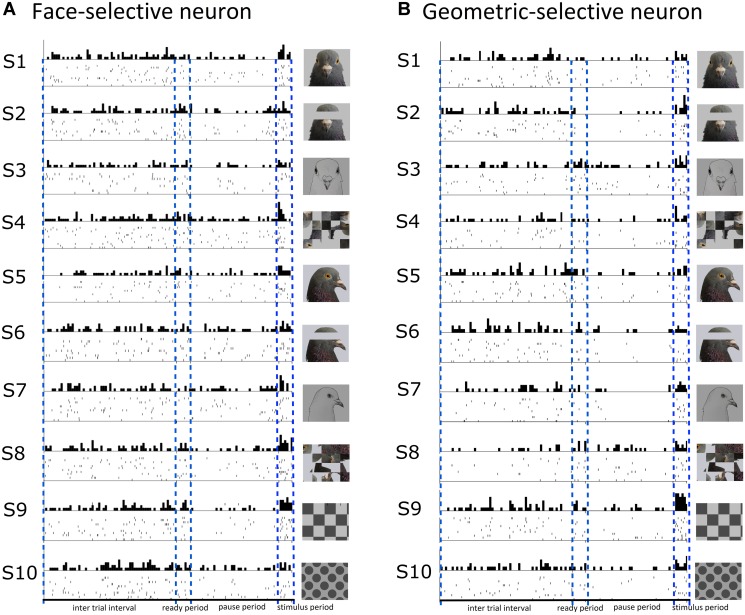
Raster and histogram plots of a neuron classified as face-selective (A) and geometric-selective (B). (A) Example of a neuron in the posterior entopallium that exhibited excitatory firing at a significant level to the stimulus S1 (portrait face) relative to the ITI, but also responded to the other stimuli during the stimulus period. (B) A neuron in the posterior entopallium that fired in an excitatory manner at a significant level to a geometric stimulus S9 (checkerboard) relative to the ITI.